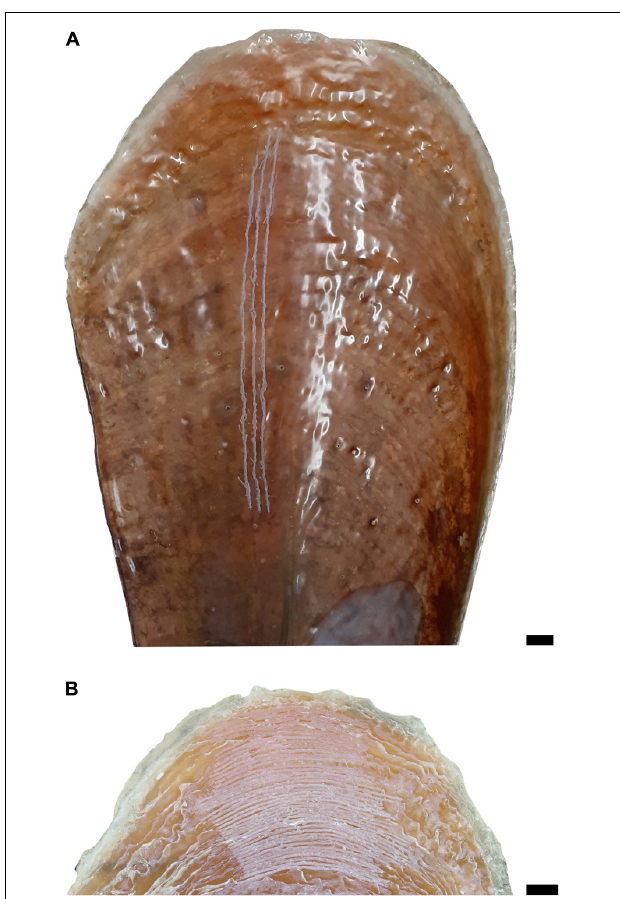
FIGURE 2 | Illustration of milling lines on (A) inner shell surface and (B) external shell surface of Pinna nobilis Kas1 collected at Kaštela Bay. Scale bar 1 cm.